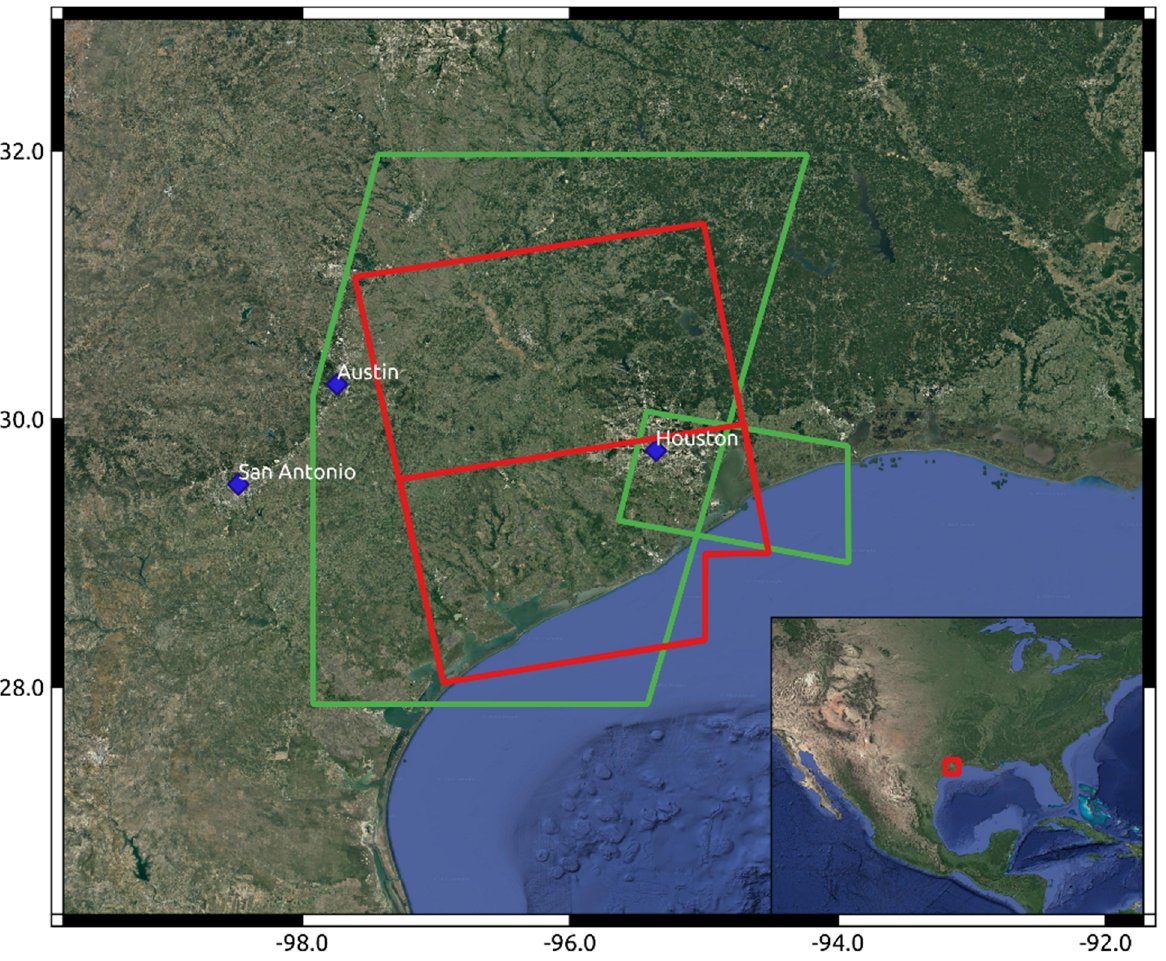
Figure 1. Map of study area. Red squares outline of the two ascending SAR images used in this analysis, 29 August 2017. The northern SAR image is Path 34, Frame 95, and the southern SAR scene is Path 34, Frame 90. The Sentinel-2 scenes are outlined in green; the large swath was acquired on 30 August 2017, and the smaller scene on 1 September 2017.